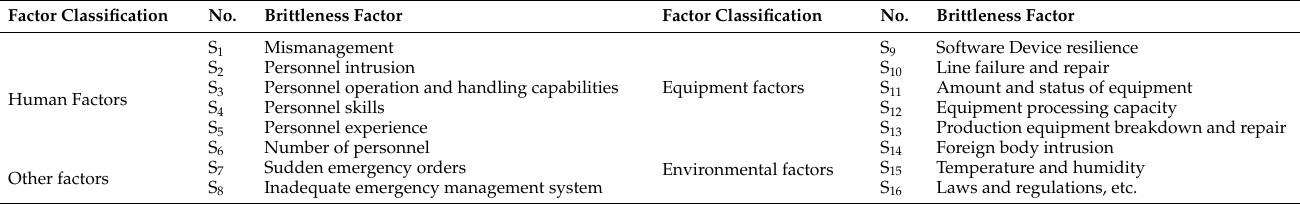
Table 1. Causal factors of brittleness in lean–green manufacturing systems in the context of Industry